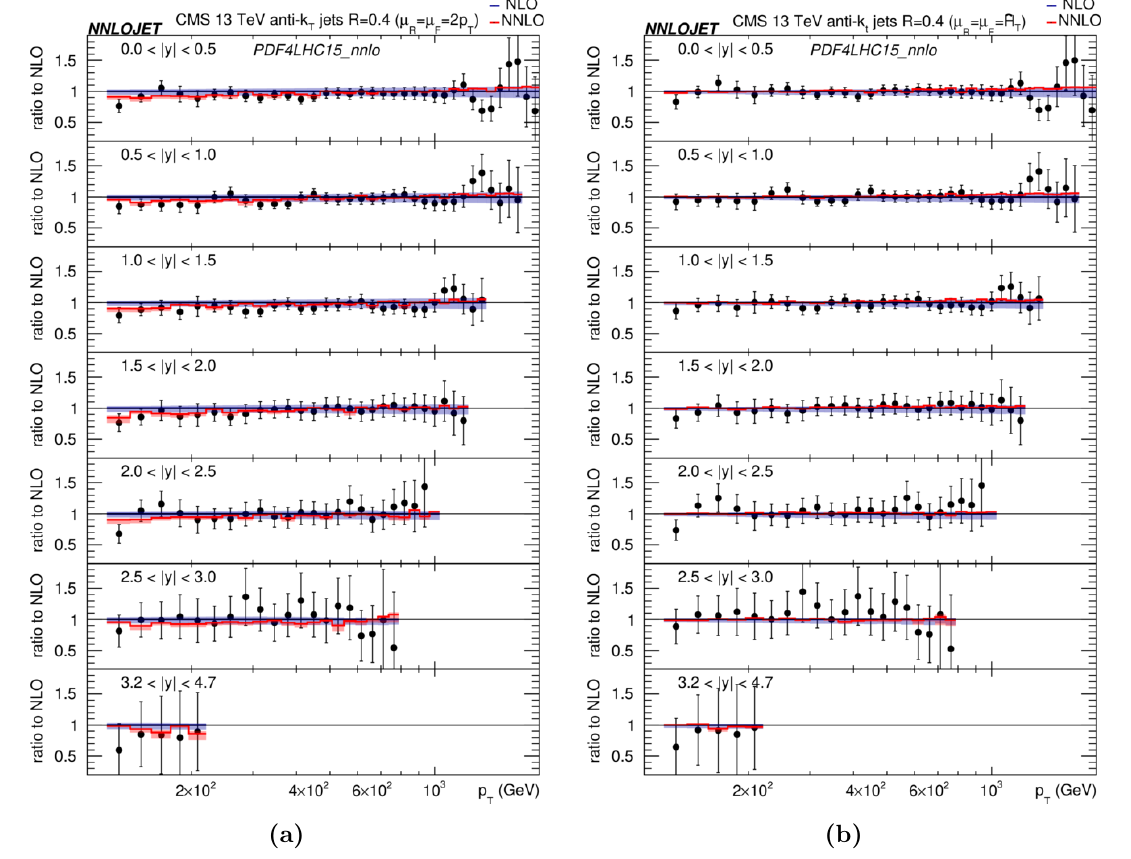
Figure 22 . Double-di(cid:11)erential single jet inclusive cross-sections measurement by CMS [12] and NNLO perturbative QCD predictions as a function of the jet p T in slices of rapidity, for anti- k T jets with R = 0 : 4 normalised to the NLO result for (a) (cid:22) = 2 p T , (b) (cid:22) = ^ H T scales. The shaded bands represent the scale